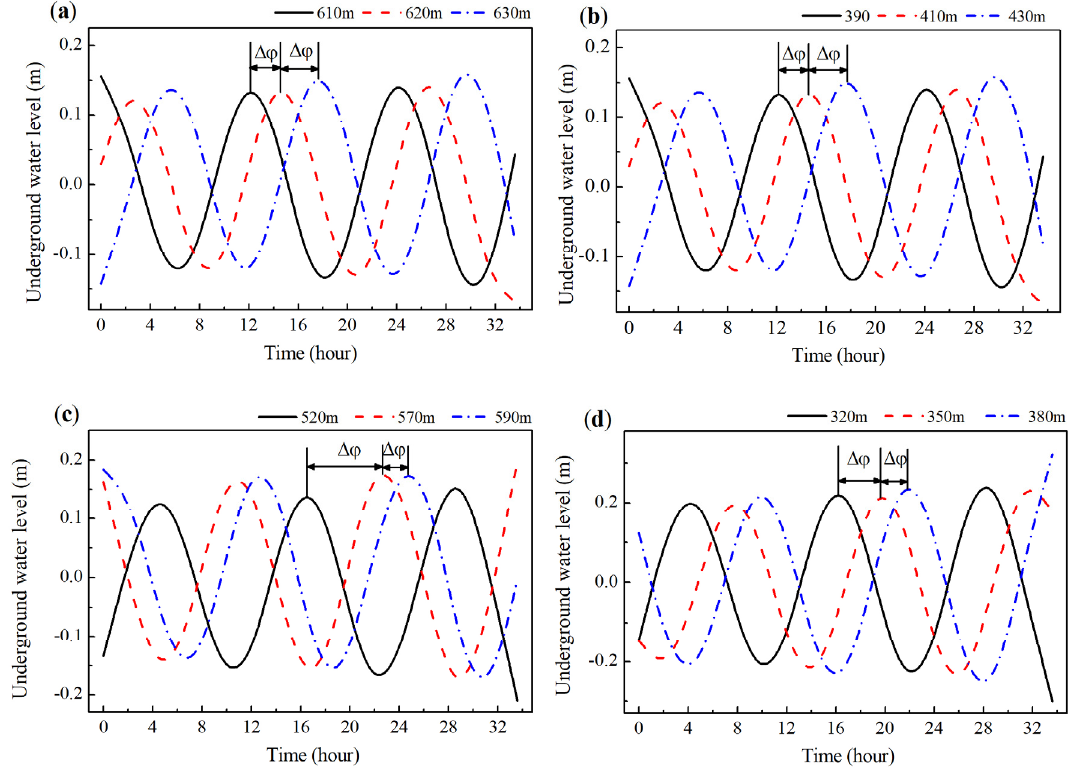
Figure 12. Groundwater level fluctuation with different distance from shoreline: ( a ) un-excavated; ( b ) excavated; ( c ) horizontal water curtain; ( d ) vertical water curtain; ∆φ phase difference.